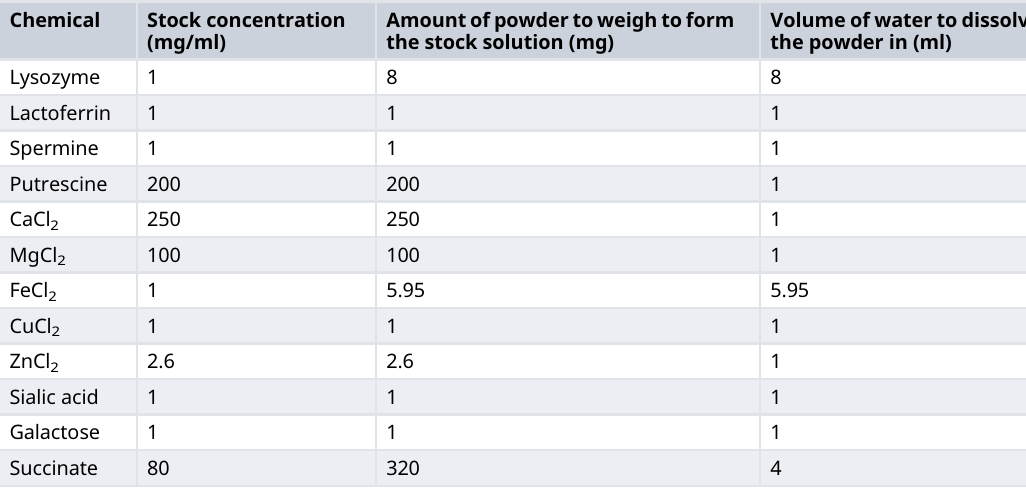
Table 11. Preparation of chemical stocks for healthy lungs media. Chemical stock preparation for healthy lungs media